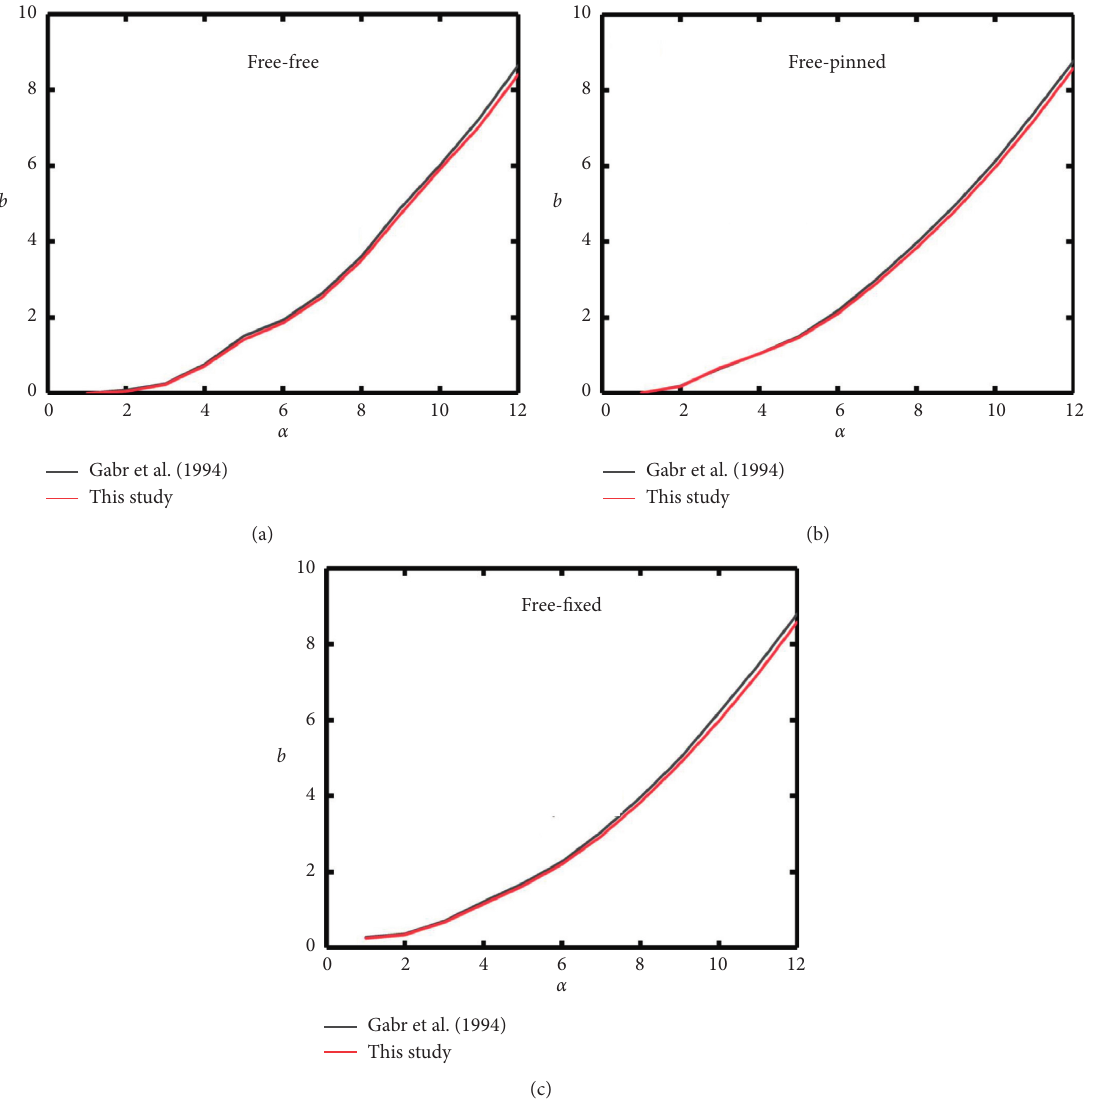
Figure 2: The buckling load factors of the uniform friction piles obtained by using the model of Gabr [14] and this study, for three different boundary conditions: free-free, free-pinned, and